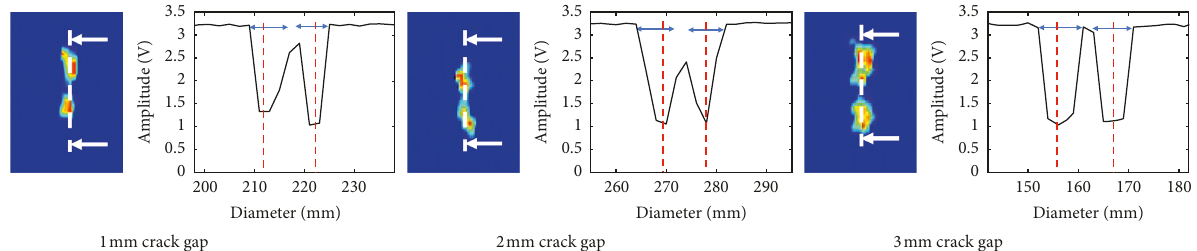
Figure 19: Inspection results for 7mmV-double type crack: C-scan (left) and cross section amplitude (right).